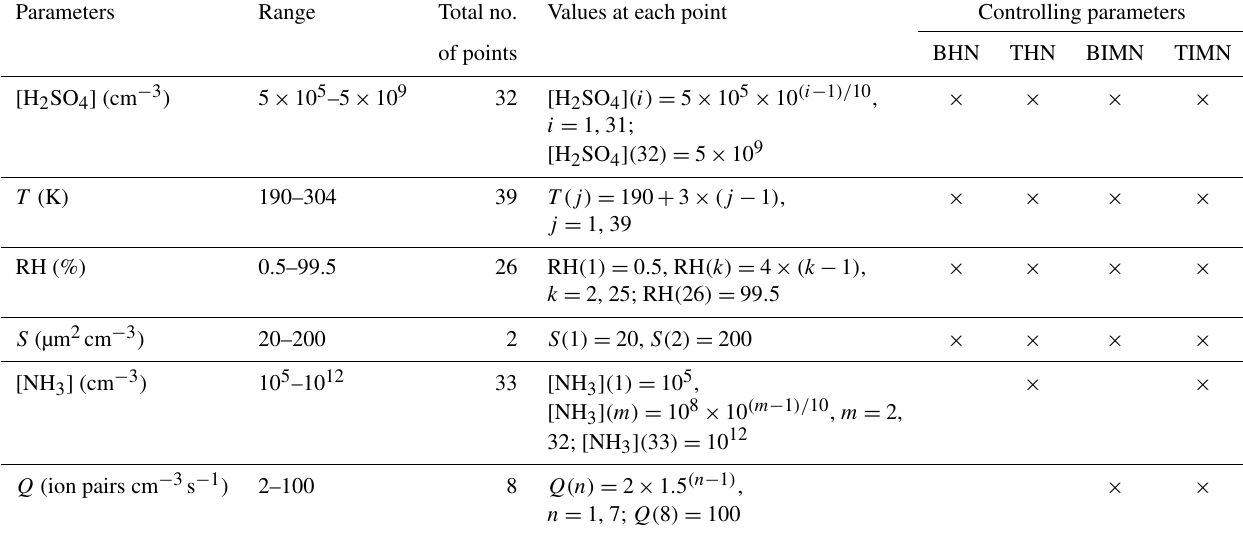
Table 1. The range of values for each independent variable in the BHN, THN, BIMN, and TIMN nucleation rate lookup tables. Also given are the total number of values for each variable, the specific values at which nucleation rates have been calculated, and controlling parameters for the four nucleation